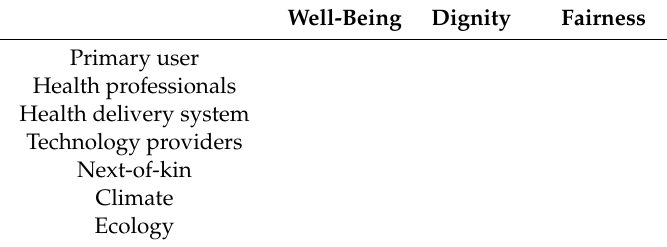
Table 1. Stakeholders 3 a ff ected by the GPS